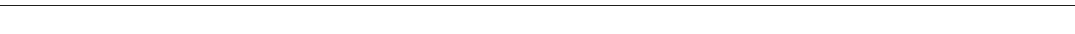
Fig. 5 RPL-11.2 and RPL5 are required for nucleolar stress induced upregulation of PHA-4. a Confocal microscopy of PHA-4::GFP { wgIs37[pha-4 :: GFP] } in WT and rrp-8 ( kun54 ) worms at 1 day of adulthood under treatment of control (empty vector, EV), rpl-11 . 1 , rpl-11 . 2 , and rpl-5 RNAi from L2/L3 larvae stage, respectively. BF, bright fi eld. Representative animals; the anterior is indicated on the left, and the posterior is indicated on the right. Scale bar represents 10 μ m. b Quanti fi cation of the fl uorescence intensity of PHA-4::GFP from a . Data are presented as the means ± SD of at least 20 worms for each worm strain. Signi fi cant difference between WT and rrp-8 ( kun54 ) mutant background, Student ’ s t -test, *** P < 0.001. c Ef fi ciency of RNAi knockdown (KD). Relative mRNA expression of rpl-11 . 1 , rpl-11 . 2 , and rpl-5 was measured by QPCR in rrp-8 ( kun54 ) worms treated with its corresponding RNAi clone from the L2/L3 larvae stage. Data are presented as the means± SD of three biological repeats. Signi fi cant difference between the control (empty vector, EV) and a speci fi c gene of RNAi bacteria, Student ’ s t -test, ** P < 0.01, * P < 0.05. d Nile Red staining of fi xed WT, rrp-8 ( kun54 ) and rsks-1 ( ok1255 ) worms treated with empty vector (EV), rpl-11 . 2 , and rpl-5 RNAi from the L2/L3 larvae stage. Representative animals; the anterior is indicated on the left and the posterior is indicated on the right. Scale bar represents 20 μ m. e Percentage of triacylglycerol (% TAG) in total lipids (TAG + phospholipids, PL) analyzed by TLC/GC. Data are presented as the means± SD of three biological repeats. Signi fi cant difference between a speci fi c mutant strain without (EV) and with RNAi knockdown, Student ’ s t -test, *** P < 0.001. f Distribution of the lipid droplet size (% lipid droplets) measured by Nile Red staining of fi xed worms from d . Data are presented as the means ± SD of 10 animals for each worm strain. Signi fi cant difference between a speci fi c mutant strain without (EV) and with RNAi knockdown, Student ’ s t -test, *** P <